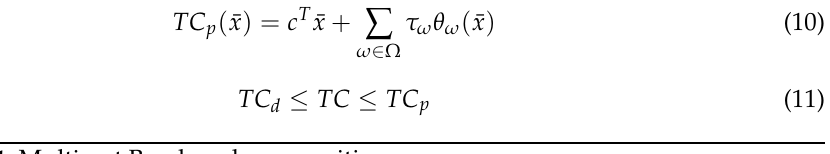
Algorithm 1: Multi-cut Benders